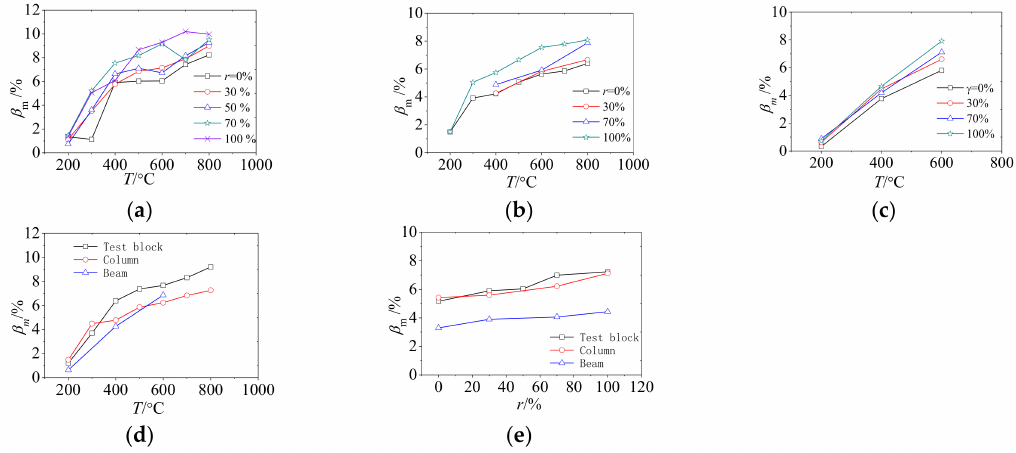
Figure 6. Mass loss ratio of specimens. ( a ) rectangular prisms specimens; ( b ) columns; ( c ) beams; ( d ) The influence of temperature on different components; ( e ) The influence of replacement percentage on different components